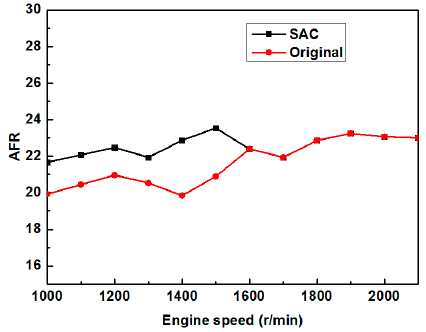
Figure 9. Full load optimization results. AFR.